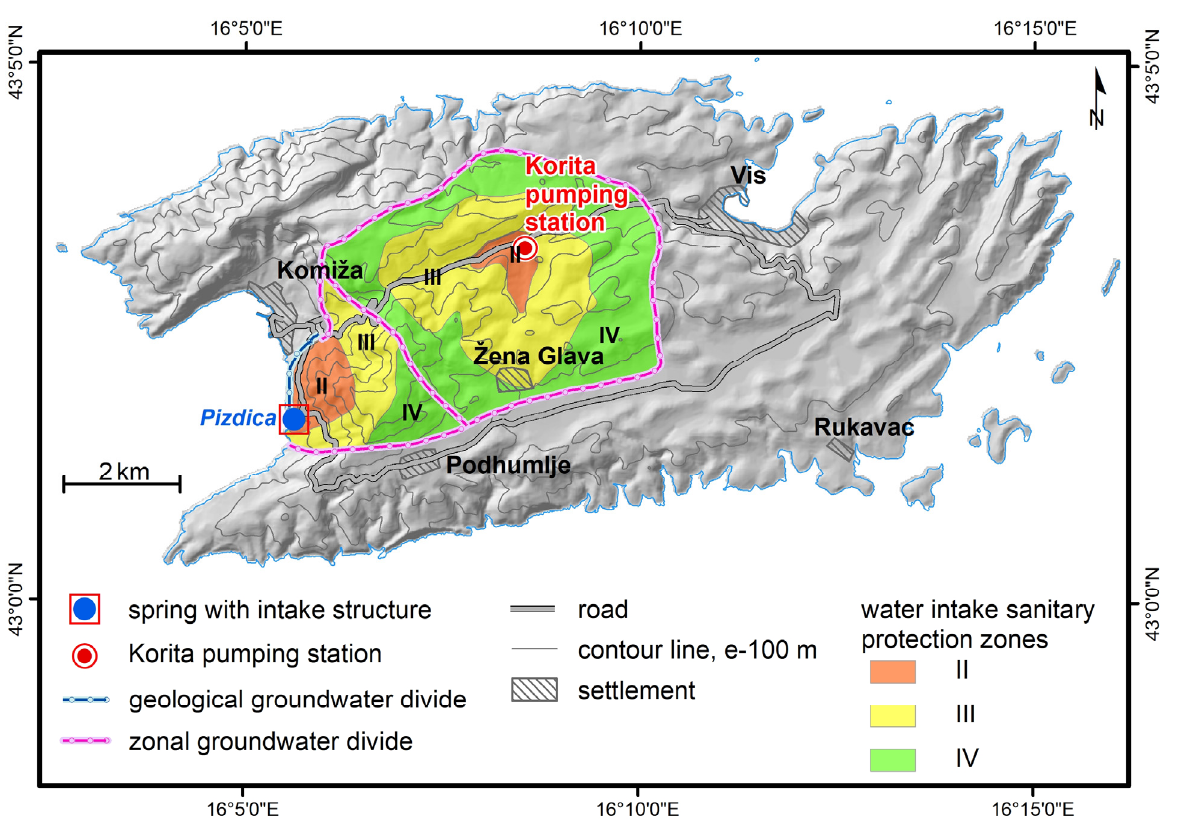
Figure 11. Sanitary protection zones on Vis Island.